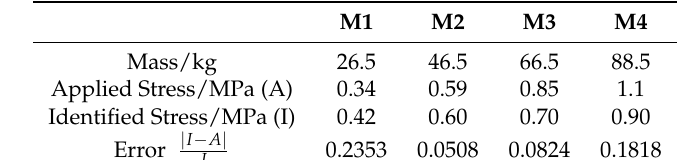
Table 4. The average identified load results of moving loads experiments.